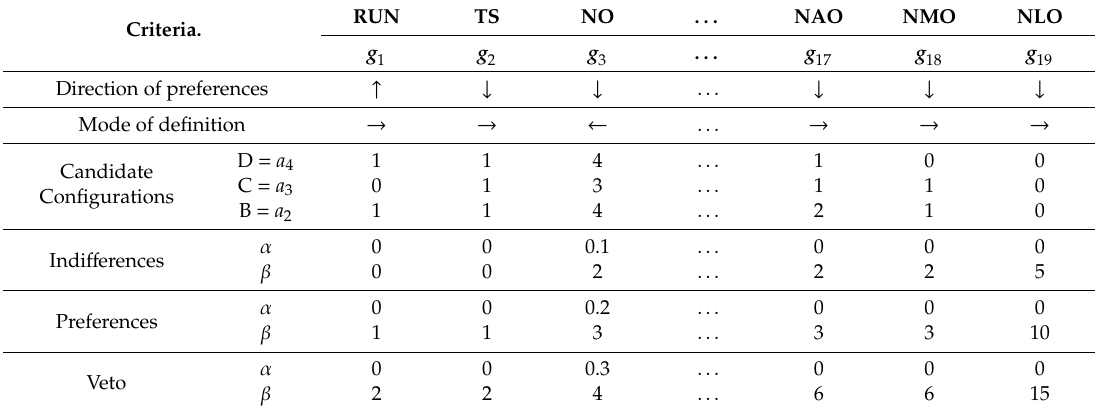
Table 12. Definition of the pseudo-criteria.